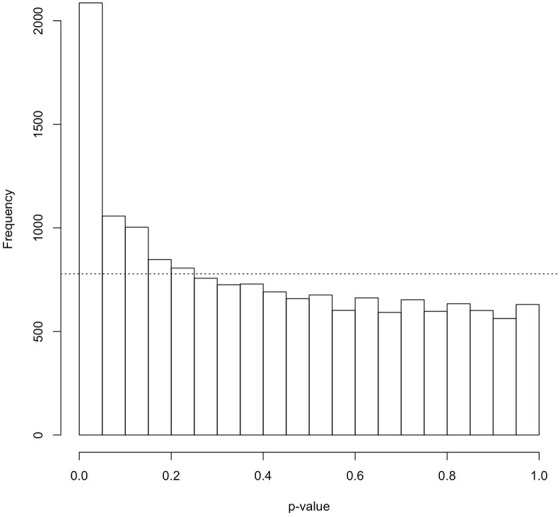
p-value distribution for transcriptional response to glucose in all 22 individuals (RGAll) (no diabetes, nDR, and PDR).Plotted are limma-derived differential expression p-values for 11,548 genes. The dashed line represents the expected null distribution. Source and code files for this plot are available in Figure 1—source data 6 and Source code 3.